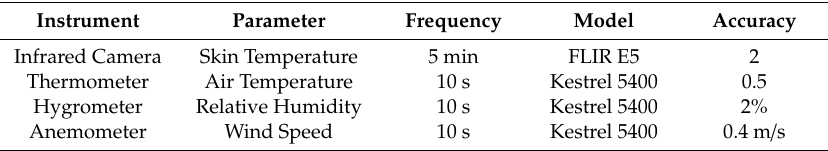
Table 3. Instruments utilized for data collection